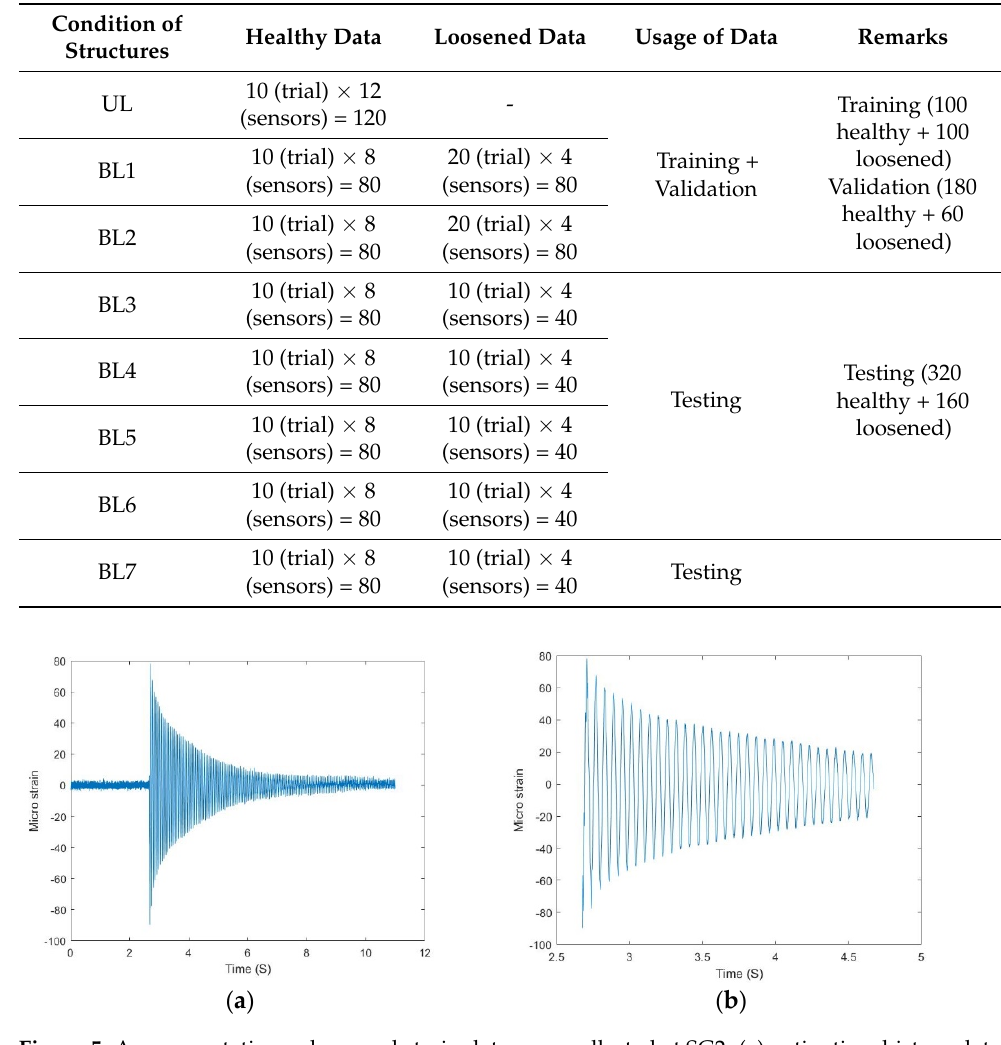
Table 3. Arrangement of the experimental data for training, validation, and testing.